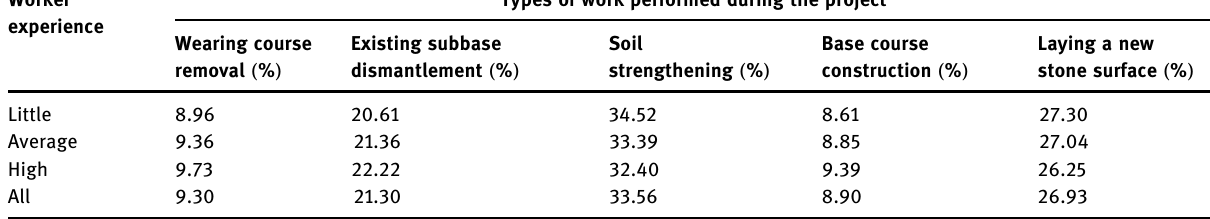
Table 9: Percentage share of the average completion time of each stage relative to the average overall project cost for various worker experience ratings ( little; average; high ) Worker